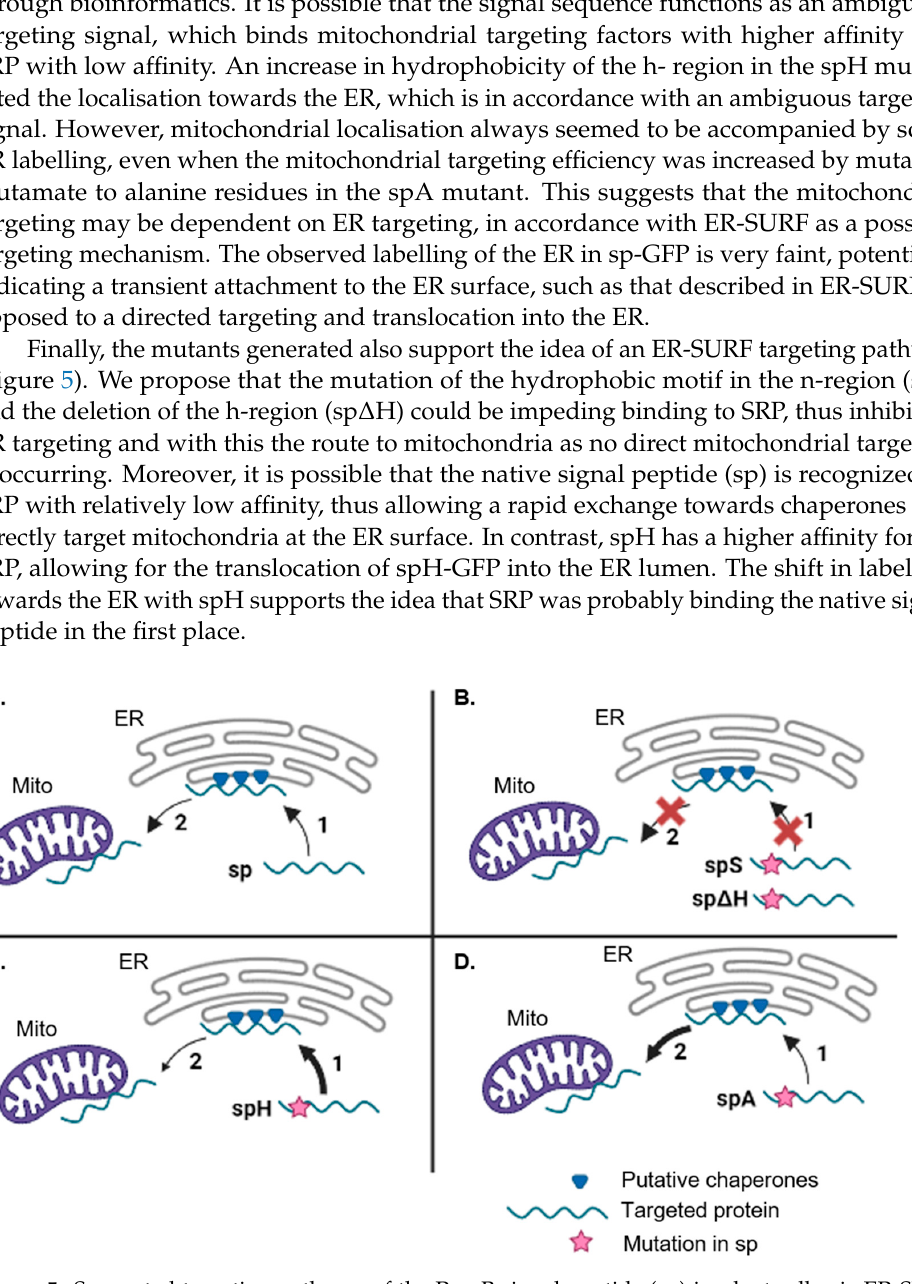
Figure 5. Suggested targeting pathway of the PmoB signal peptide (sp) in plant cells via ER-SURF. ( A ) sp-GFP is first targeted to the ER surface (i.e., by recognition of the signal peptide by SRP) where putative chaperones (blue triangles), such as plant homologues of yeast Djp1, aid in funnelling